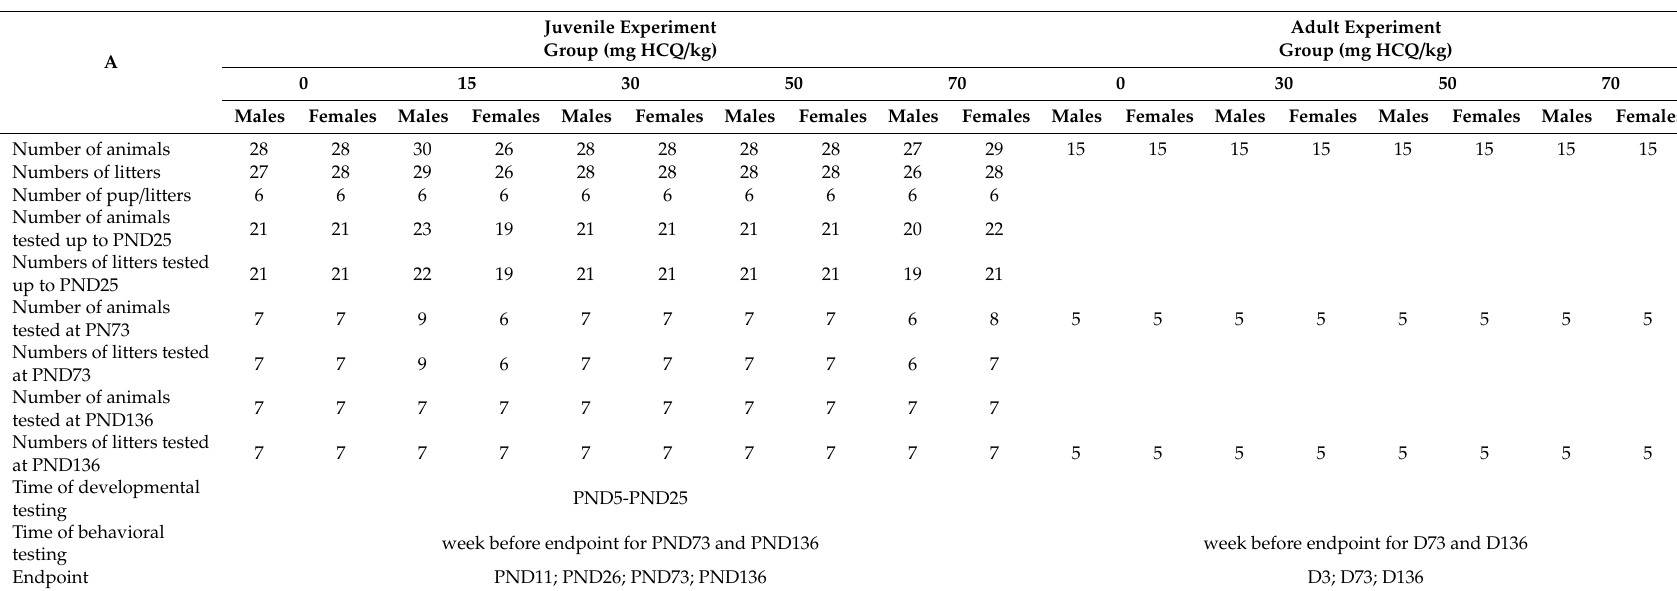
Table 1. Distribution of